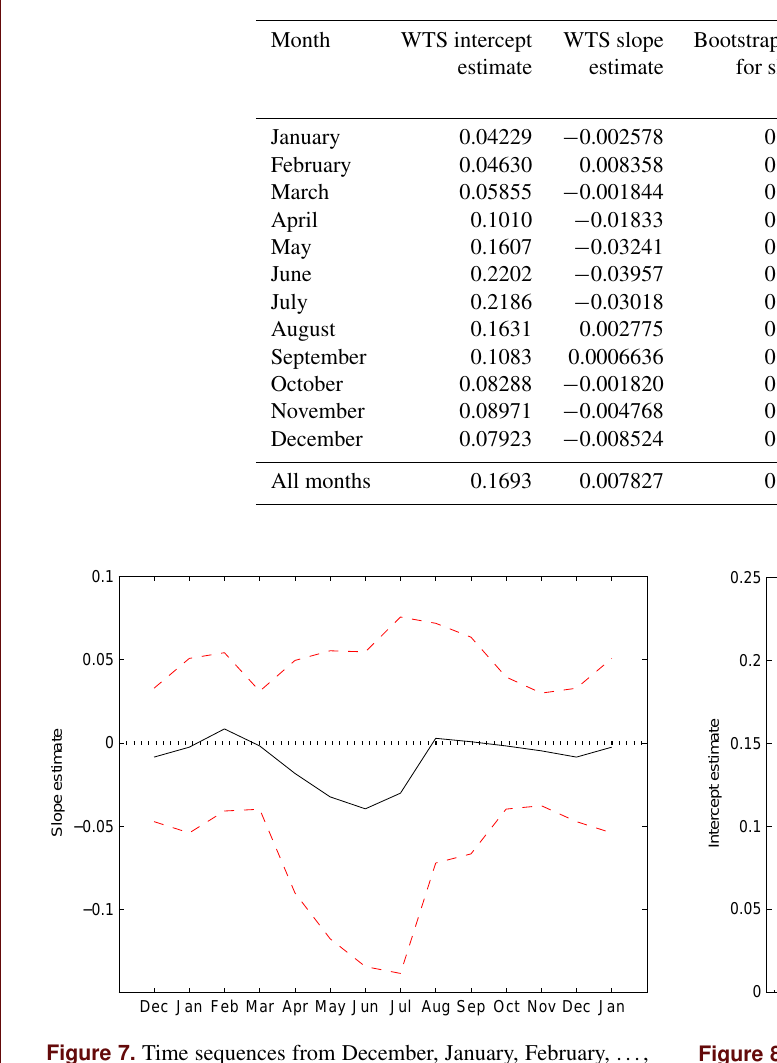
Table 2. Results from a linear regression of the spatial standard deviation, S v ( t ), on the spatial mean, v ( t ), in the Niño 3.4 region, for all t ∈ D Jan t ,t ∈ D Feb t ,...,t ∈ D Dec t , and t ∈ D t . Shown are the WTS-estimated intercept and slope coefficients for each month and for all months combined. Also shown are bootstrap (using 1000 replicates) standard deviations (SD) and 95% confidence intervals.